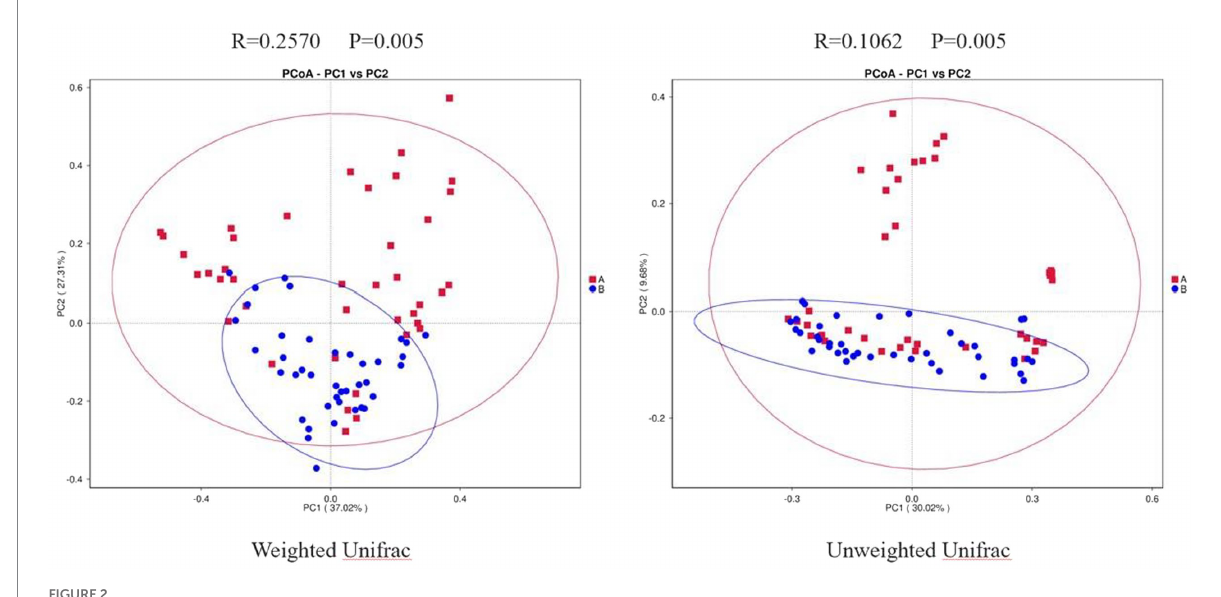
FIGURE 2 Two-dimensional PCoA Plots. The horizonal axis and vertical axis represent different principal components. Percentage represents the contribution of principal component to sample difference. A, osteoarthritis group; B, healthy control group.